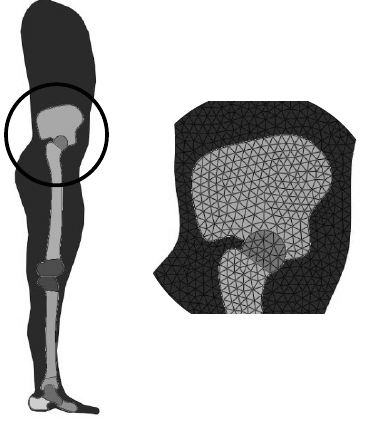
Figure 2. Numerical model of lower limb (left); mesh detail of hip joint region (right). Table 2. Anthropometric table for a virtual subject 175 cm tall.